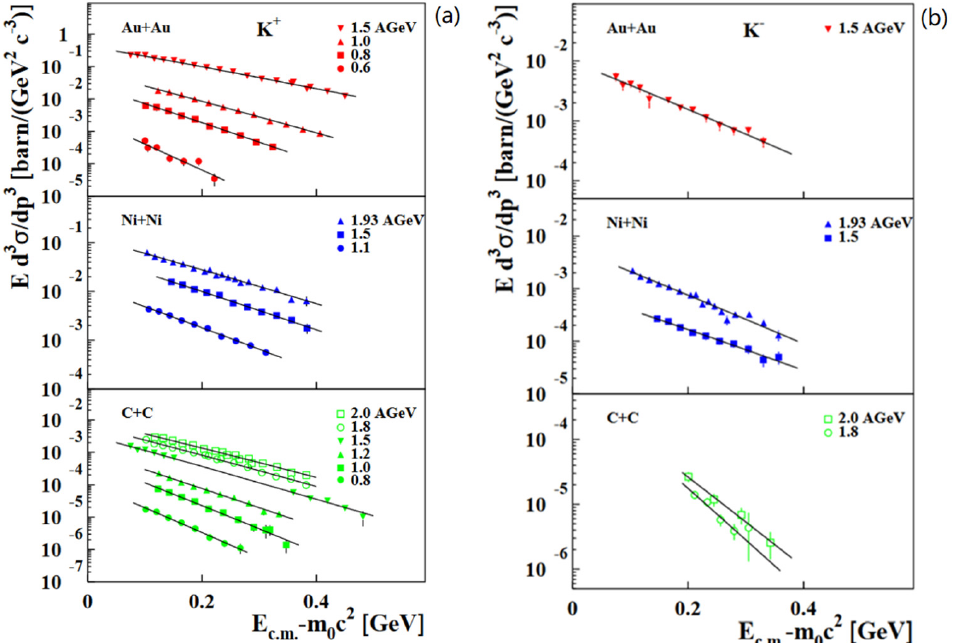
Particles 2022 , 5, FOR PEER REVIEW 10 Figure 8. Inclusive invariant cross-sections at mid-rapidity as a function of the kinetic energy E c . m . − m 0 c 2 for K + mesons ( a ) and for K − mesons ( b ) for the various collision systems and beam energies measured. Mid-rapidity data were selected by the condition θ c . m .= 90° ± 10° from measurements at different polar angles [41]. The lines represent fits to the data (see text).